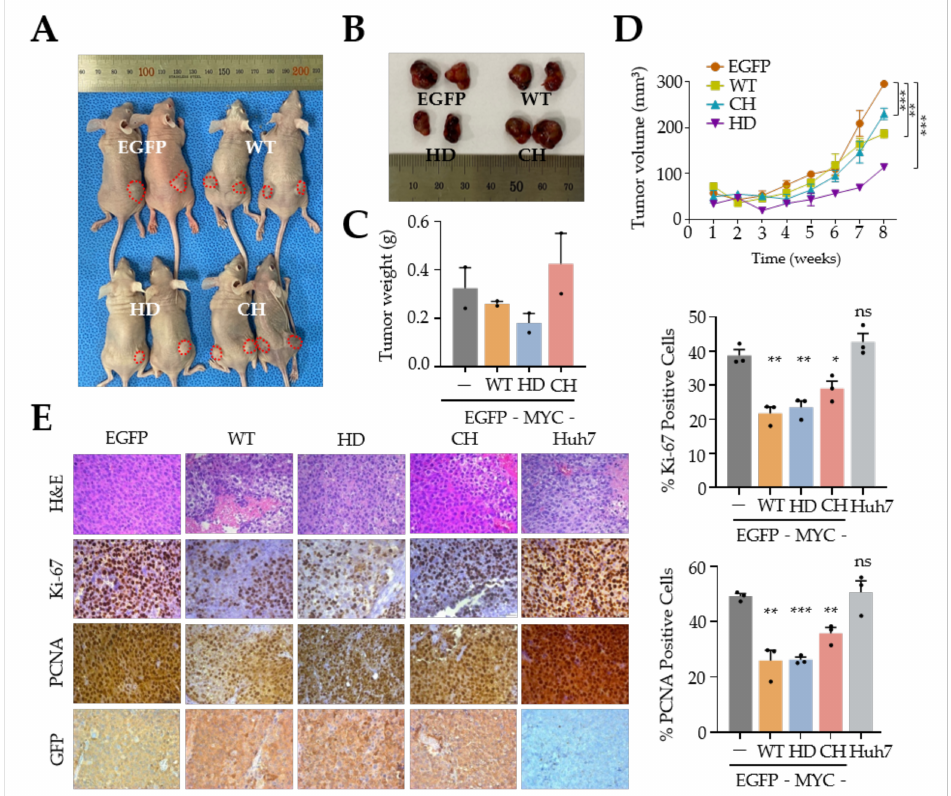
Figure 3. Overexpression of UPF1 WT and UPF1 HD attenuated tumor growth in vivo. ( A ) Repre- sentative images of tumors formed in nude mice grafted subcutaneously with Huh7 cells express- ing UPF1 variants. ( B ) Representative tumors from grafted mice 8 weeks after cell implantation. ( C ) Tumors were weighed after removal ( n = 2). ( D ) Tumor volumes were monitored weekly for 8 weeks. ( E ) Immunohistochemical staining for Ki-67 and PCNA in xenografted tumors in nude mice was performed (100 × magnification). The relative numbers of Ki67- and PCNA-expressing cells were determined. * p ≤ 0.05; ** p ≤ 0.01; *** p ≤ 0.001; ns, not